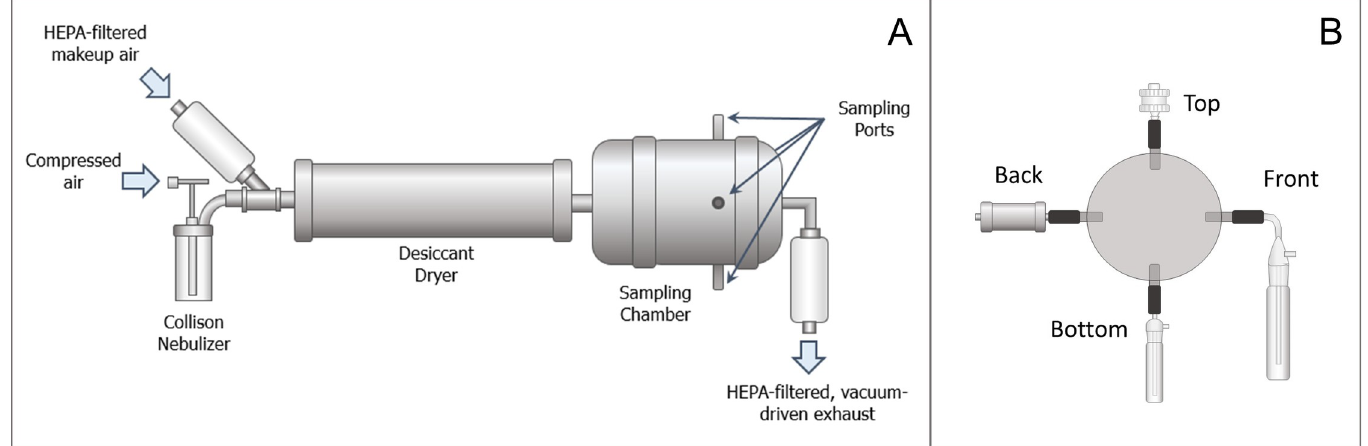
Fig 1. Aerosol test system. (A) Side view: a Collison nebulizer generated aerosols that passed through a desiccant dryer before entering the sampling chamber. The aerosol was sampled from four ports spaced evenly around the circumference of the sampling chamber; (B) Cross-sectional view at the plane of sampling ports: Samplers were connected to the sampling chamber as shown to prevent the need for any additional bends in the sampling inlets. Clockwise from top: gelatin filter in delrin holder, AGI, midget impinger, and Mercer cascade impactor.